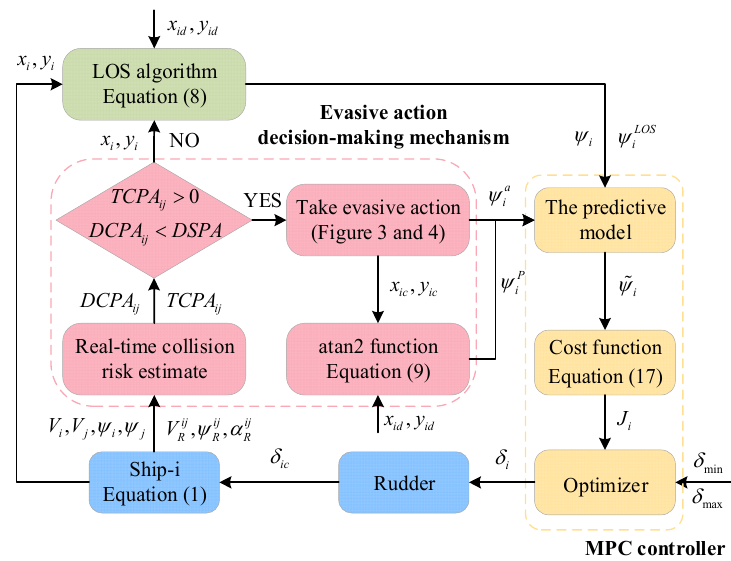
Figure 5. The diagram of COLREGS ‐ complied real ‐ time automatic collision avoidance strategy.